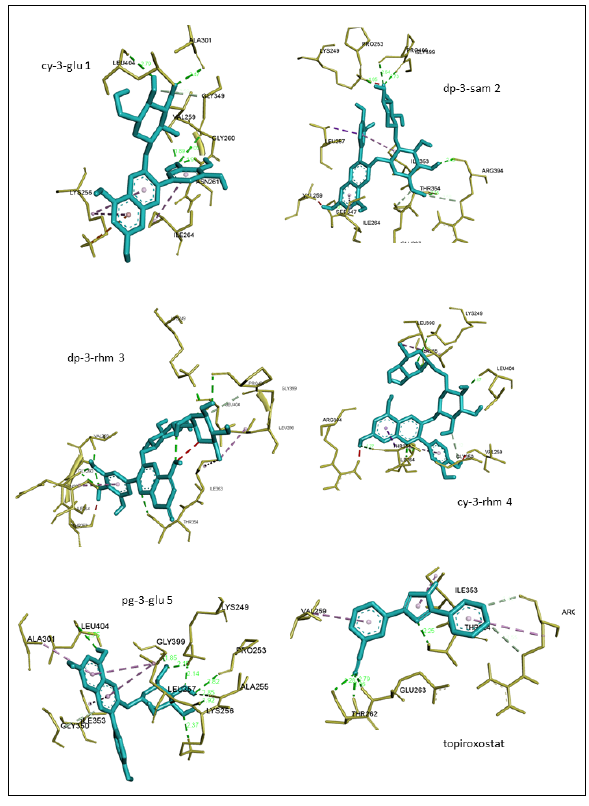
Figure 7: Binding interactions of the ligands cy-3-glu 1, dp-3-sam 2, dp-3-rhm 3, cy-3-rhm 4, pg-3-glu 5 and topiroxostat. Hydrogen bonds between the binding amino acid residues at the flavin adenine dinucleotides binding site and ligands. The ligand structures are shown in light blue, amino acid residues in pale yellow, and classical H-bonds are in